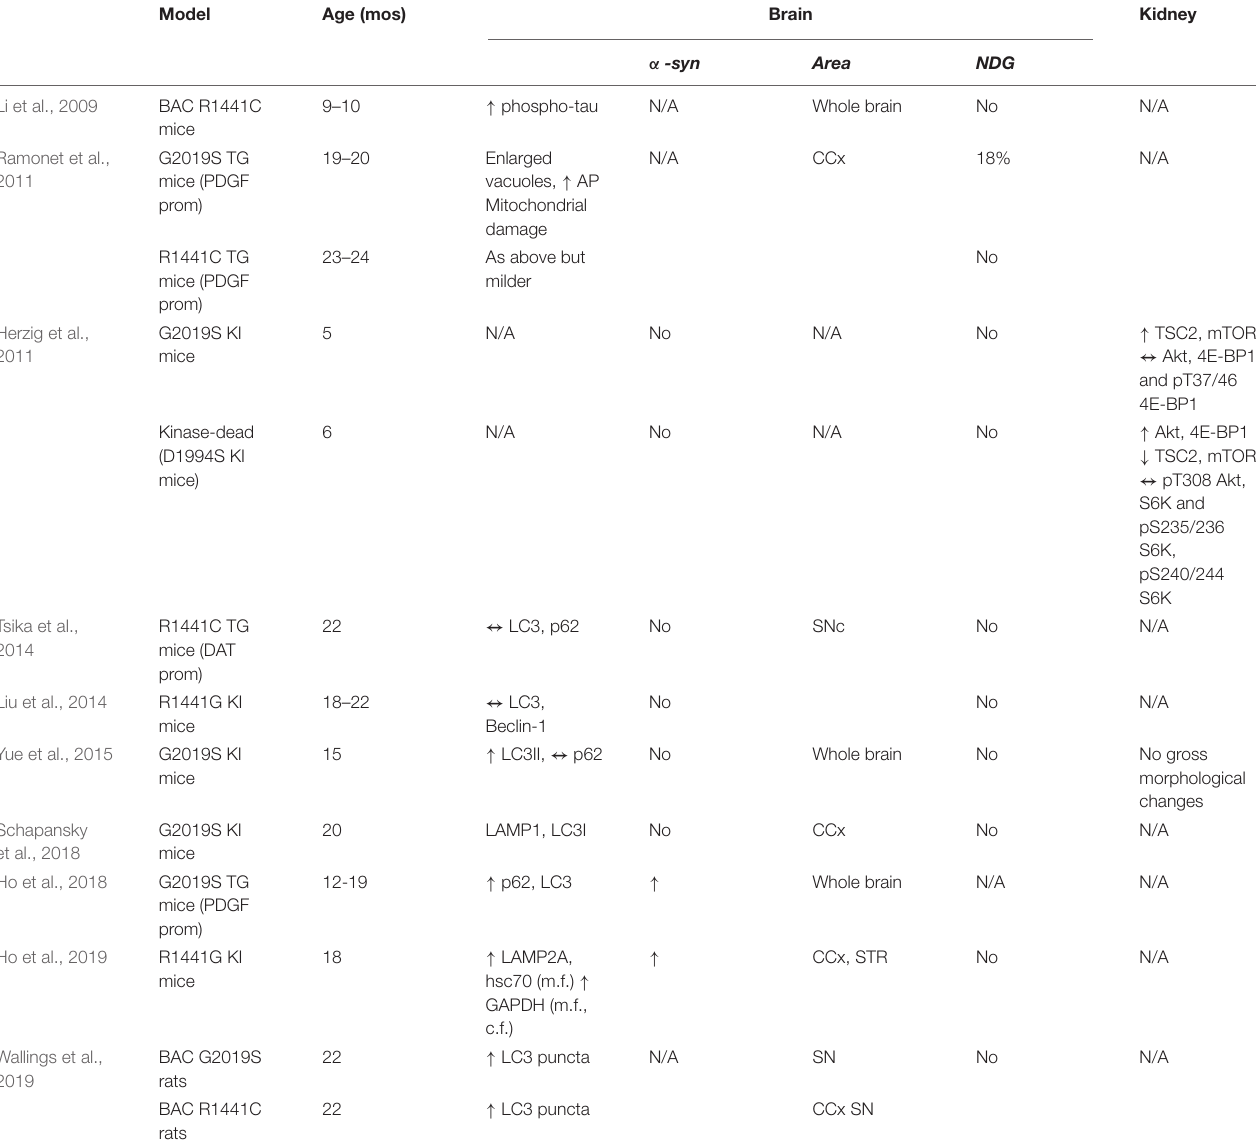
TABLE 3 | Changes in autosomal-lysosomal pathways in LRRK2 mutant mice and rats in